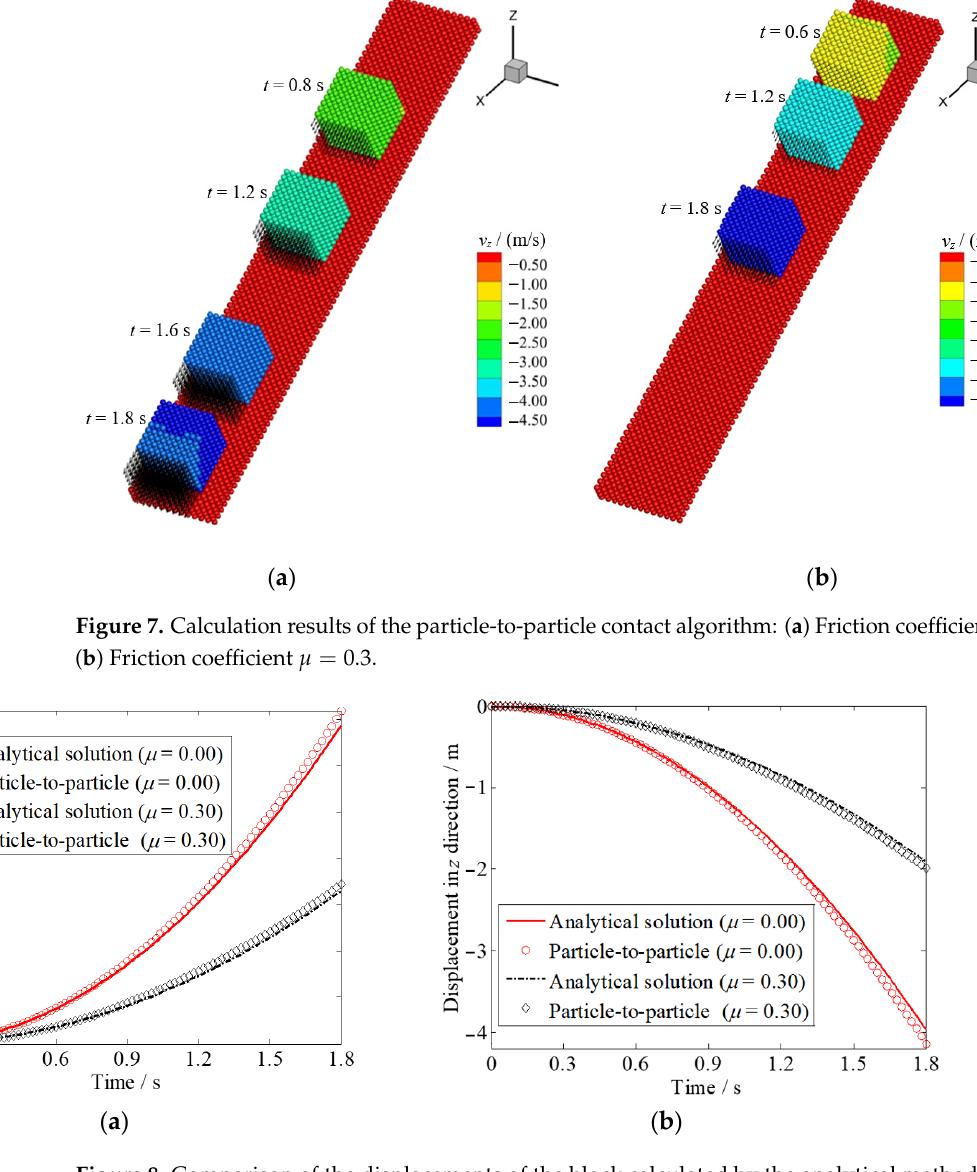
Figure 8. Comparison of the displacements of the block calculated by the analytical method and the particle-to-particle contact algorithm: ( a ) Displacement in x -direction; ( b ) Displacement in z -direction.